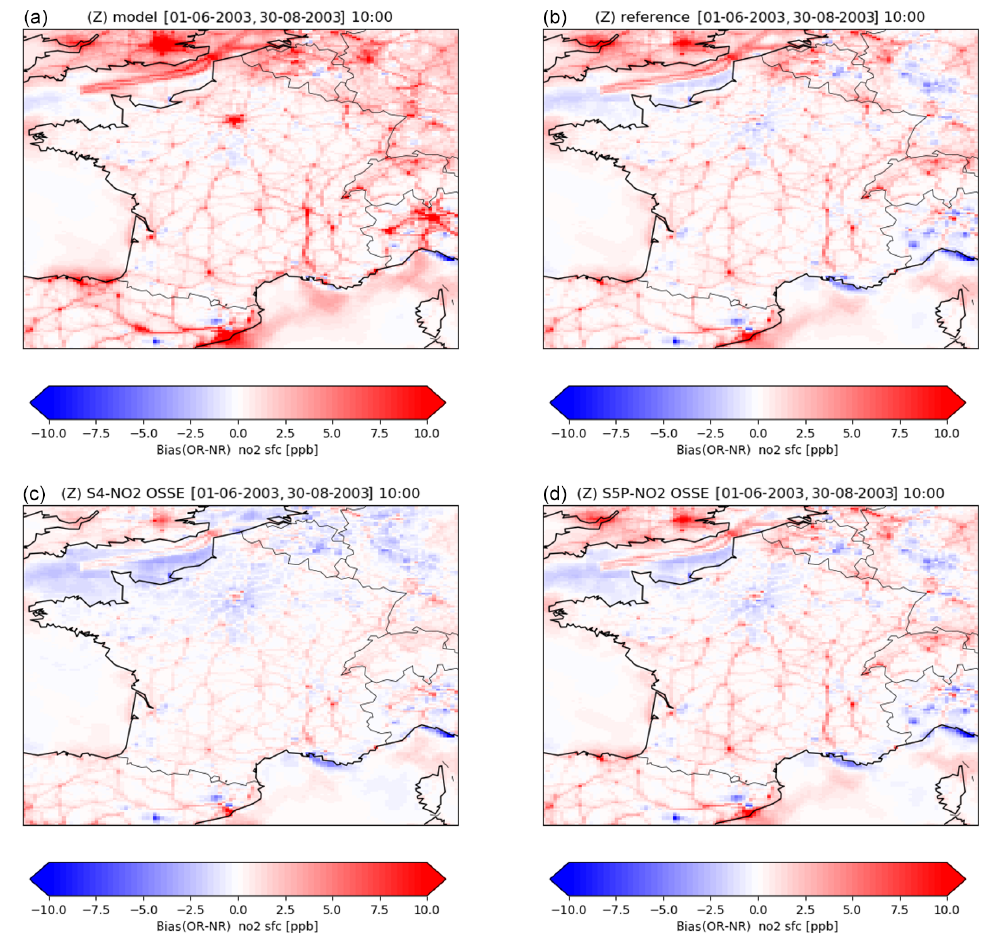
Figure 14. Zoom domain: summer, 10:00UTC average. Bias with NR surface NO 2 before assimilation (a) and after assimilation of ground- based O 3 (b) , ground-based O 3 + S4 NO 2 (c) or ground-based O 3 + S5P NO 2 .